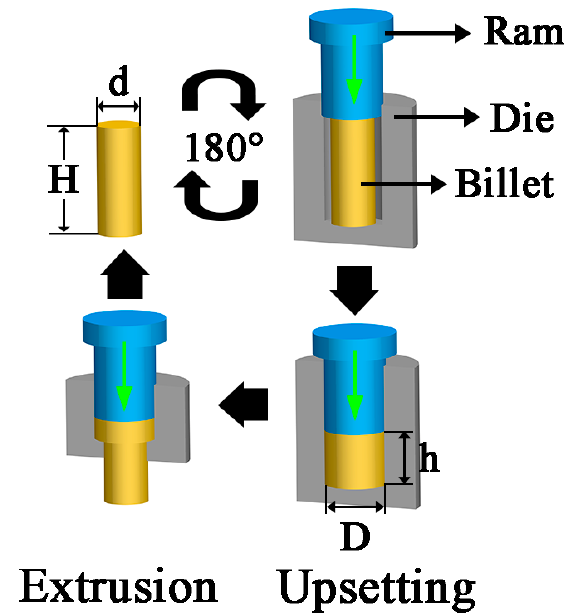
Figure 1. The principle of the repetitive upsetting extrusion (RUE) processing.